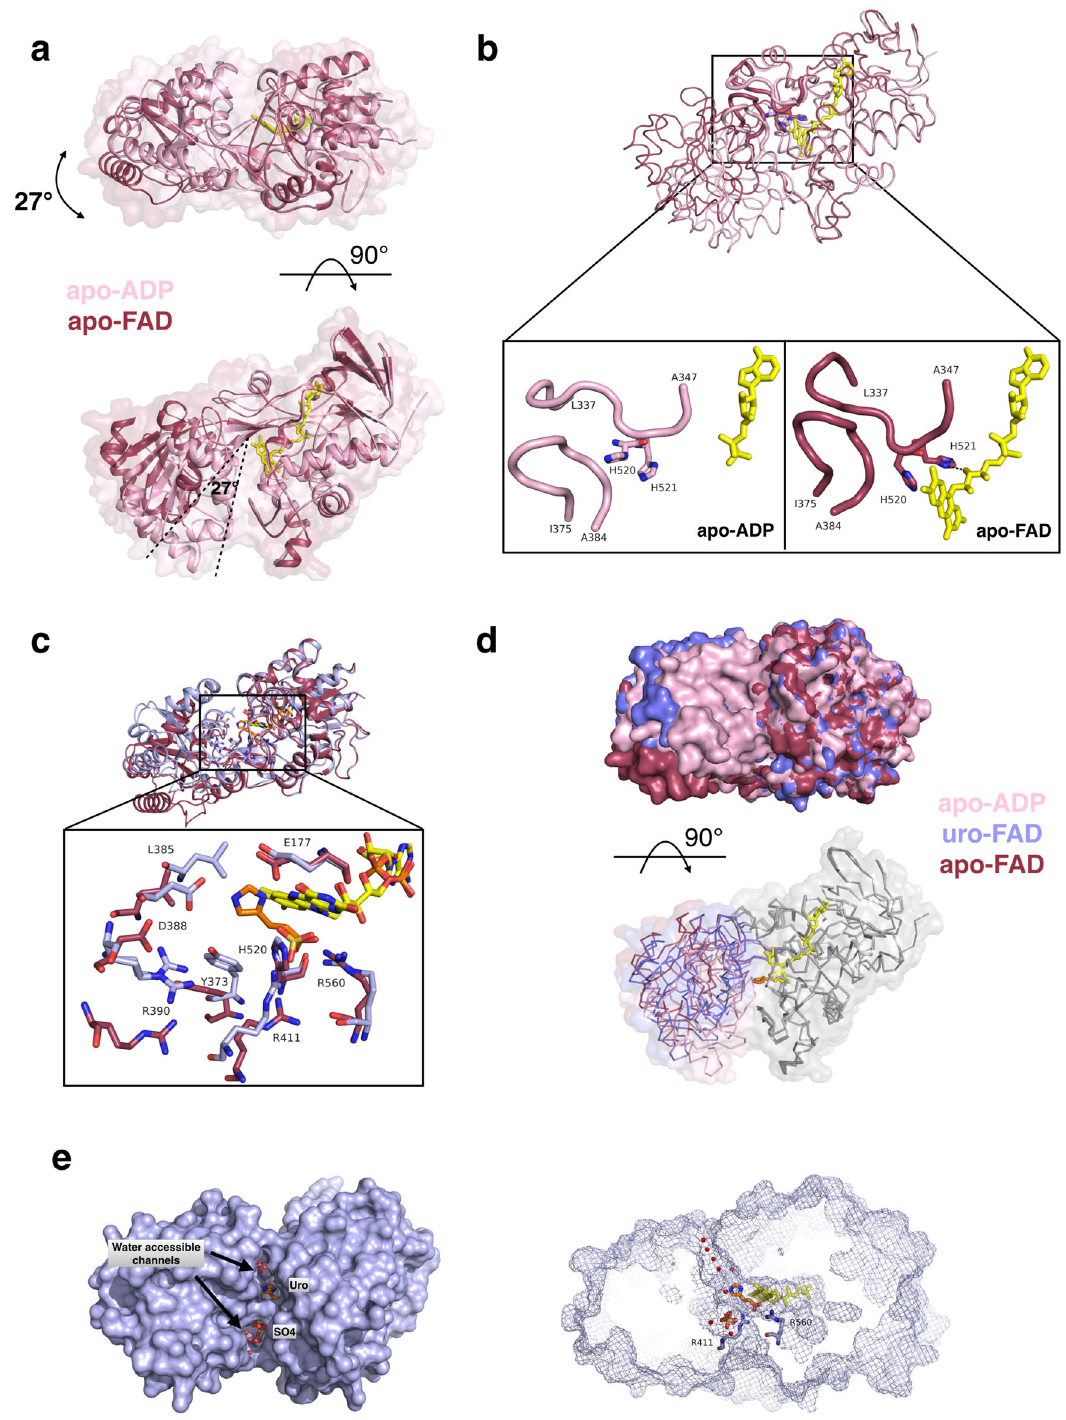
Fig. 3 Conformational changes of the clamp domain upon ligand binding. a Domain movement in closed/open structures. Superimposition of apo-FAD (red) and apo-ADP (pink) structures on FAD domain. The FAD and ADP are shown as sticks in yellow. Degree of clamp-domain rotation indicated as calculated using DynDom 6 . b FAD induced conformational changes. Comparison of apo-FAD (red) and apo-ADP (pink) structures, superimposed on the FAD domain. Flexible loops are shown in a thicker cartoon. His520 and His521 are shown as sticks, H-bond as a dashed line, ADP/FAD shown in yellow. c The clamp domain adopts different degrees of closure upon substrate binding. The shift in binding site residues upon urocanate binding compared to apo- FAD structure (superimposed on the FAD domain). The sulfate ion bound in apo-FAD structure in the same position as carboxy group of urocanate in the uro-FAD structure is shown sticks. d Clamp-domain closure comparison in apo-ADP (pink), apo-FAD (red), and uro-FAD (light blue) structures with urocanate (orange) and FAD (yellow). The structures were superimposed on FAD domain. e Water can access the active site in the substrate – enzyme complex. Surface representation of uro-FAD (left), mesh representation of the surface at the angle to illustrate water access (right). Urocanate (orange), FAD (yellow), water molecules (red spheres), sulfate, Arg411, and R560 (light blue) are